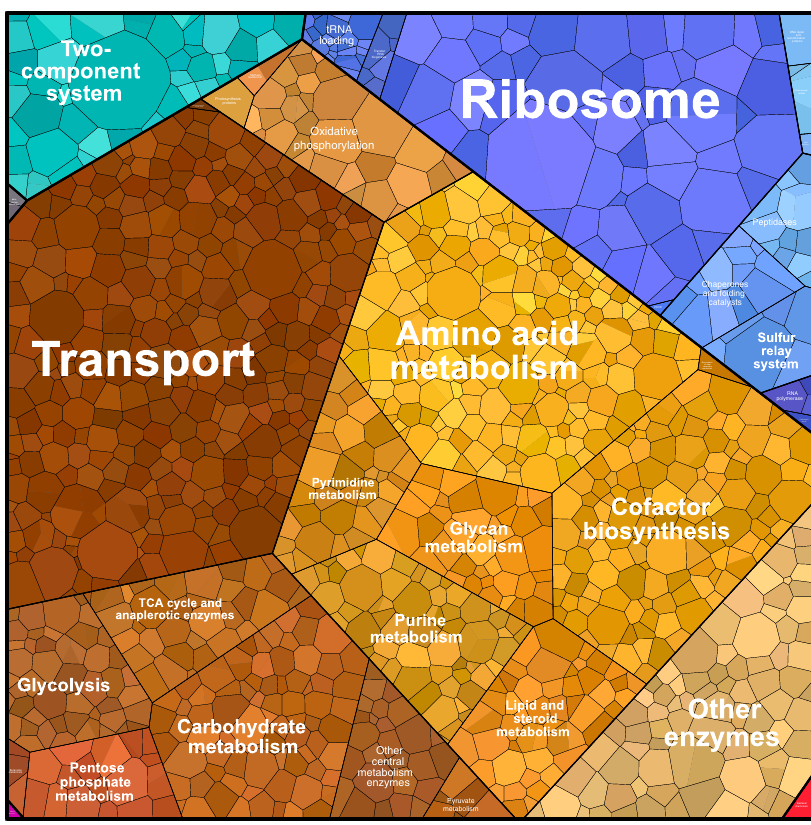
Fig. 3 Voronoi map of the predicted abundances of mRNAs. Each colored patch represents a different mRNA, with its area in proportion to its relative abundance. Genes can be clustered using KEGG Gene Ontology (GO) terms. Colors indicate the